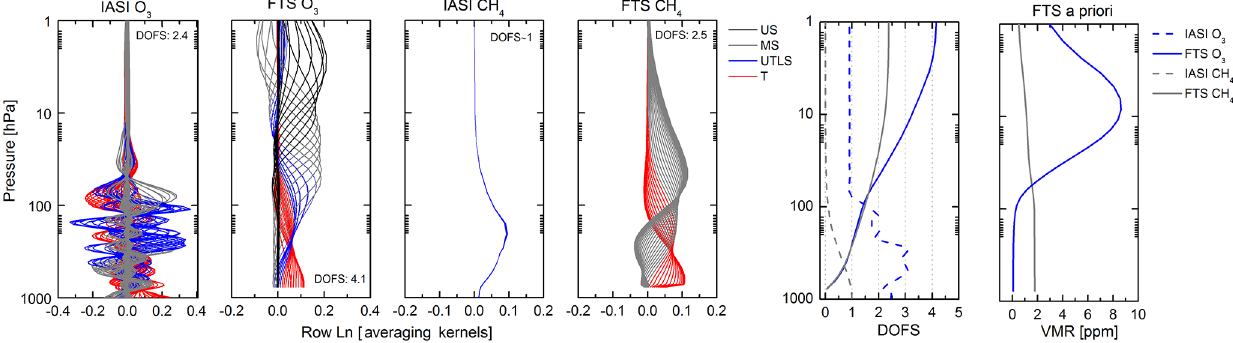
Figure 2. Row averaging kernels for O 3 and CH 4 as observed by IASI-A and FTS instruments, expressed on logarithm scale, for typical measurement conditions at IZO. US is upper stratosphere, MS is middle stratosphere, UTLS is upper troposphere and lower stratosphere, and T is troposphere. Also shown are the total degree of freedom for signal (DOFS), the vertical profile of the cumulative DOFS, as well as the a priori VMR profiles used for the FTS